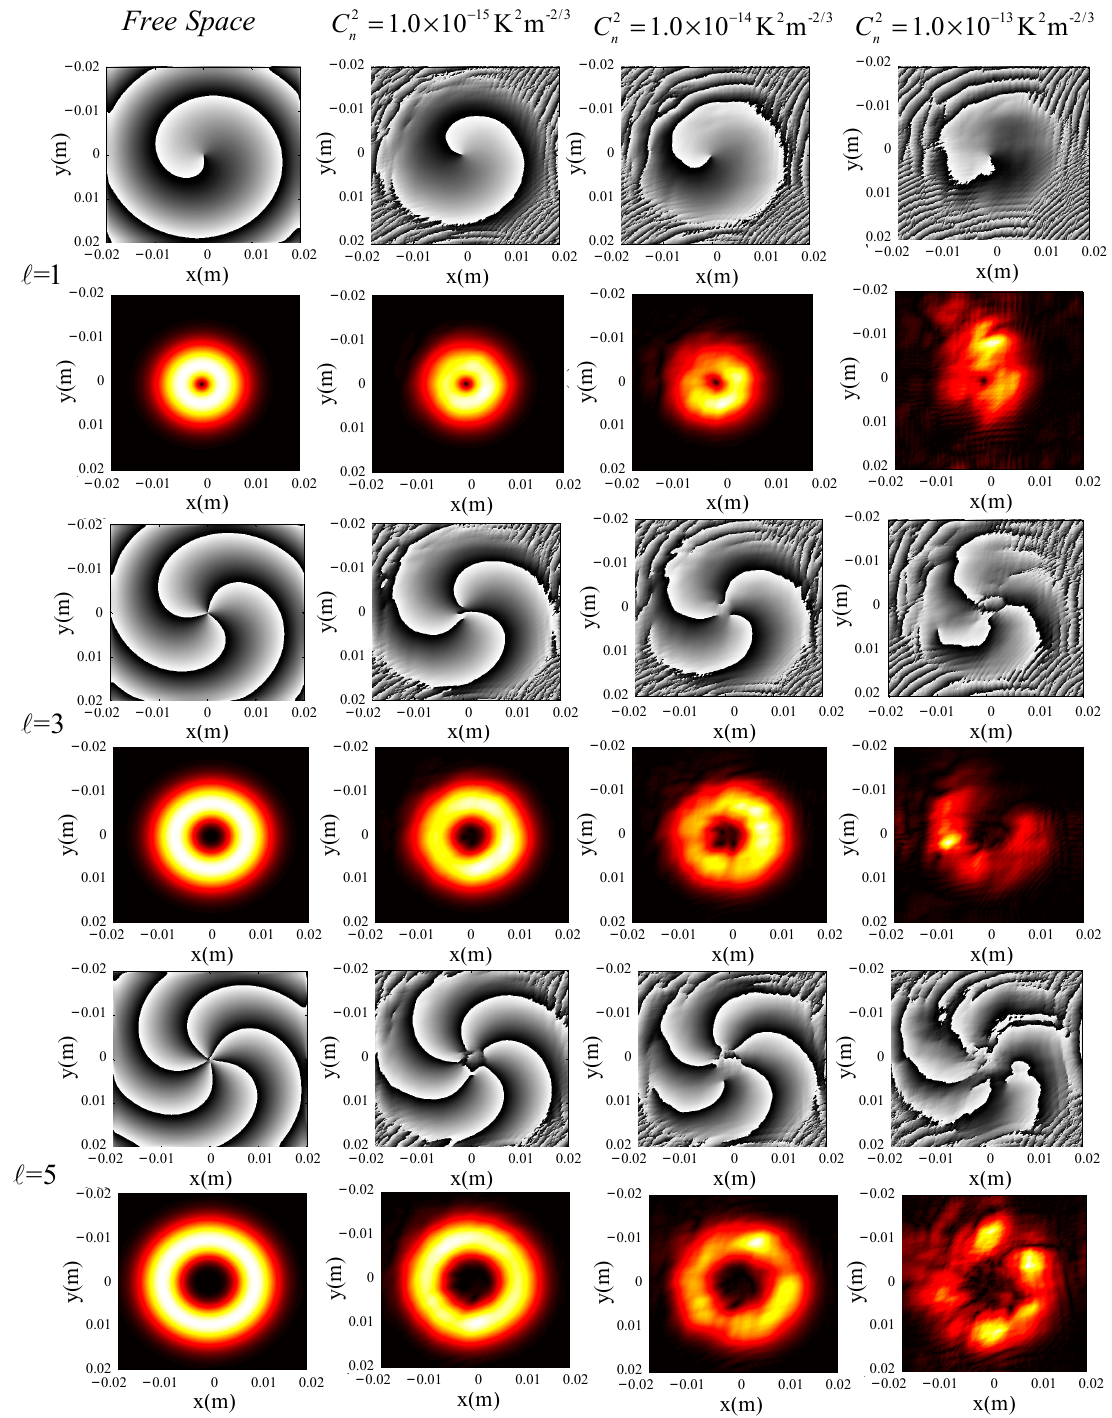
Figure 3. Intensity and phase distribution of the LG beam in the ocean turbulence channel.